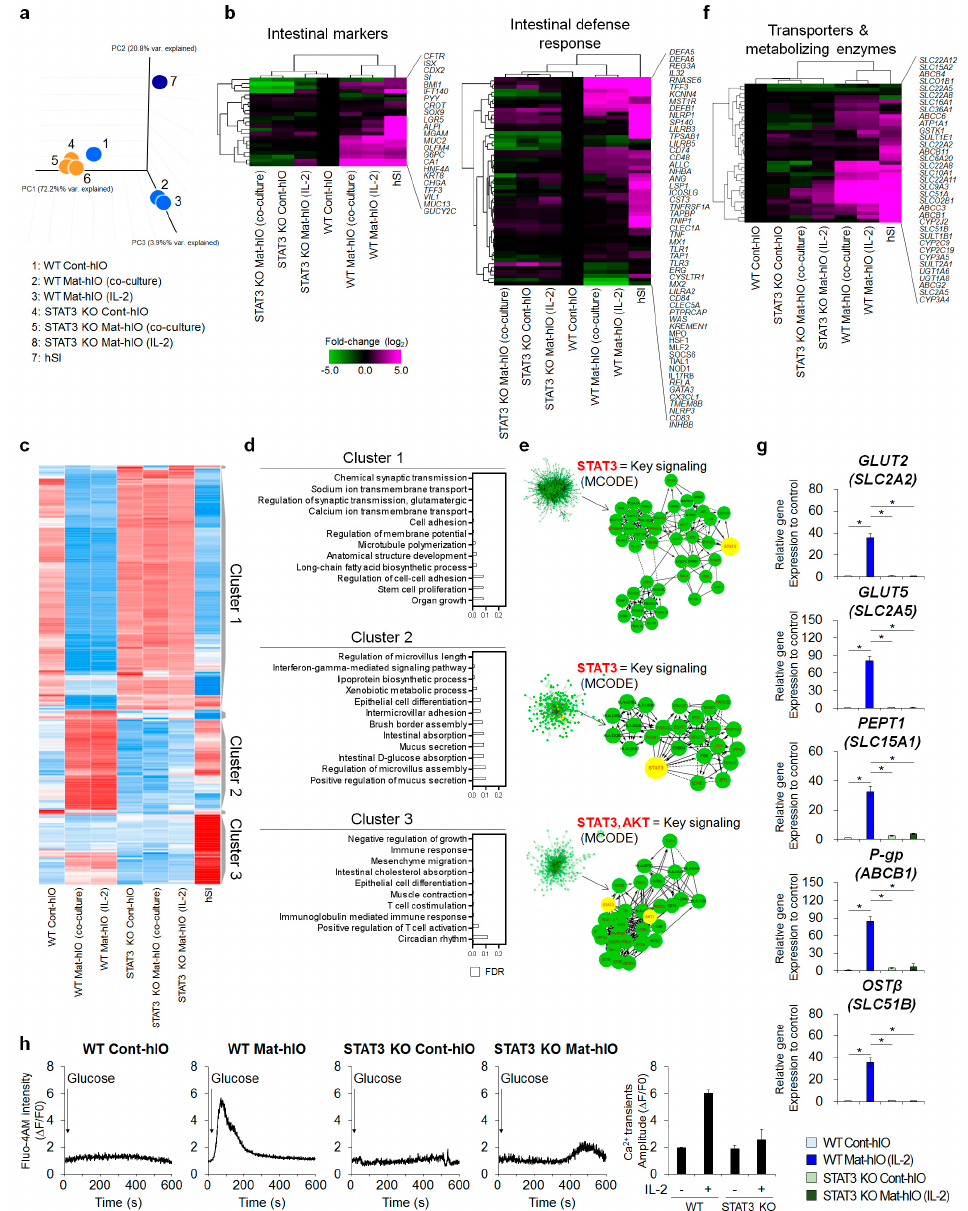
Figure 4. Transcriptomic analysis of STAT3 KO hIOs based on the microarray data. ( a ) Principal component analysis (PCA) of microarray datasets for WT hIOs and STAT3 KO hIOs with or without in vitro maturation by either IL-2 treatment or co-culture with stimulated Jurkat T lymphocytes and adult human small intestine (hSI). ( b ) Heatmaps and hierarchical clustering of genes involved in the intestinal markers and intestinal defense response in WT hIOs and STAT3 KO hIOs with or without in vitro maturation. Adult hSI was used as the control. Gene expression was normalized to that of WT Cont-hIOs (shown in black). Magenta indicates upregulated genes, whereas green indicates downregulated genes compared to those of the WT Cont-hIOs. ( c ) Heatmap of di ff erentially expressed genes (DEGs) in WT hIOs and STAT3 KO hIOs with or without in vitro maturation conditions. Three clusters classified according to the expression pattern are displayed on the right side of the heatmap. ( d ) The representative Gene Ontology (GO) pathway of genes belonging to each cluster is indicated by a bar graph according to the false discovery rate (FDR) and p -value. ( e ) The key signaling pathway enriched from reactome FI networks by MCODE, which regulates the expression of each cluster